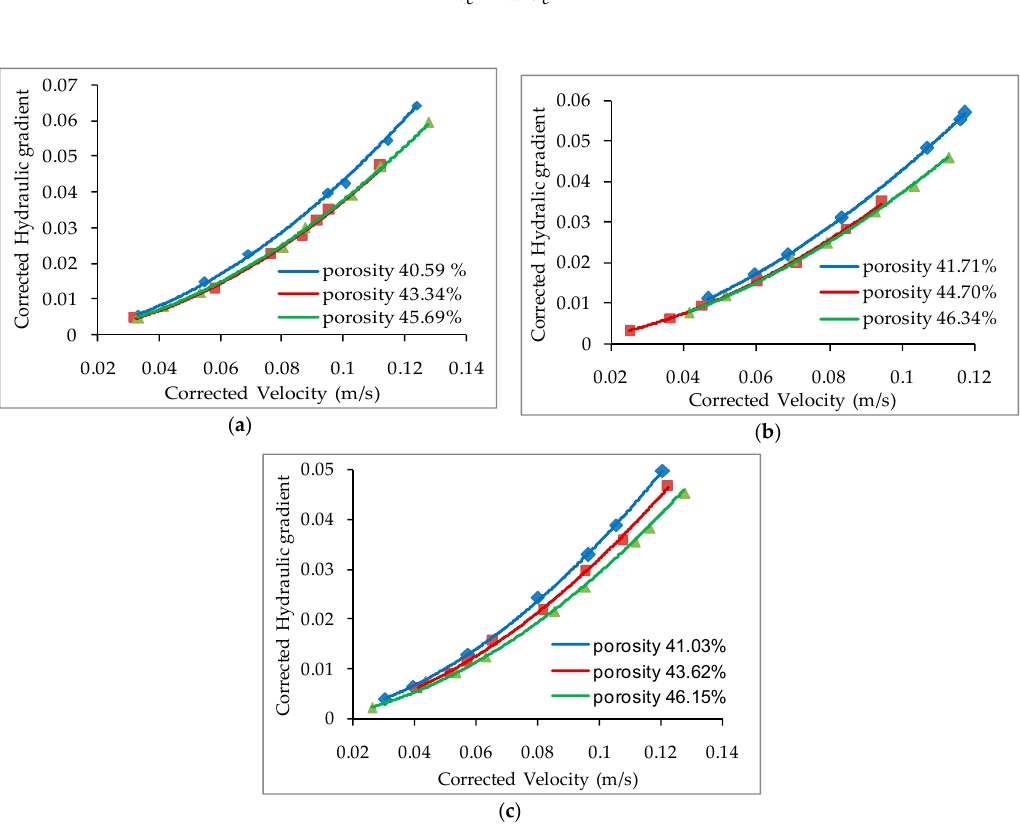
Figure 2. The variation of corrected hydraulic gradient with a corrected velocity for the media size being ( a ) 29.8 mm; ( b ) 34.78 mm; and ( c ) 41.59